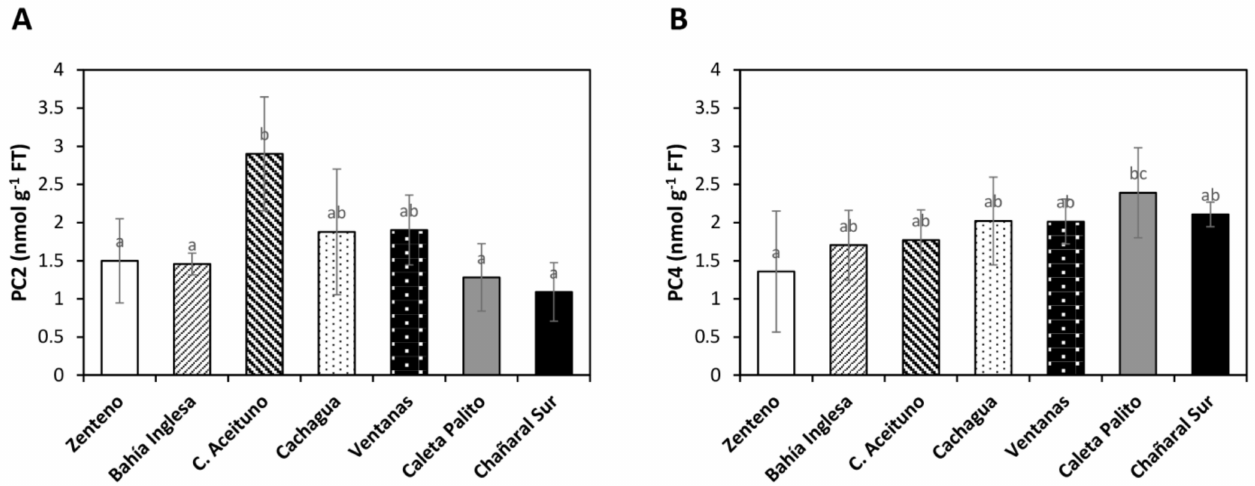
Figure 3. Level of phytochelatins, PC2 ( A ) and PC4 ( B ), in algae of control sites and copper-polluted sites. The levels of PC2 and PC4 are expressed in nanomoles per gram of fresh tissue (FT). Bars represent mean values of three independent replicates ± SD. Letters indicate significant differences ( p <